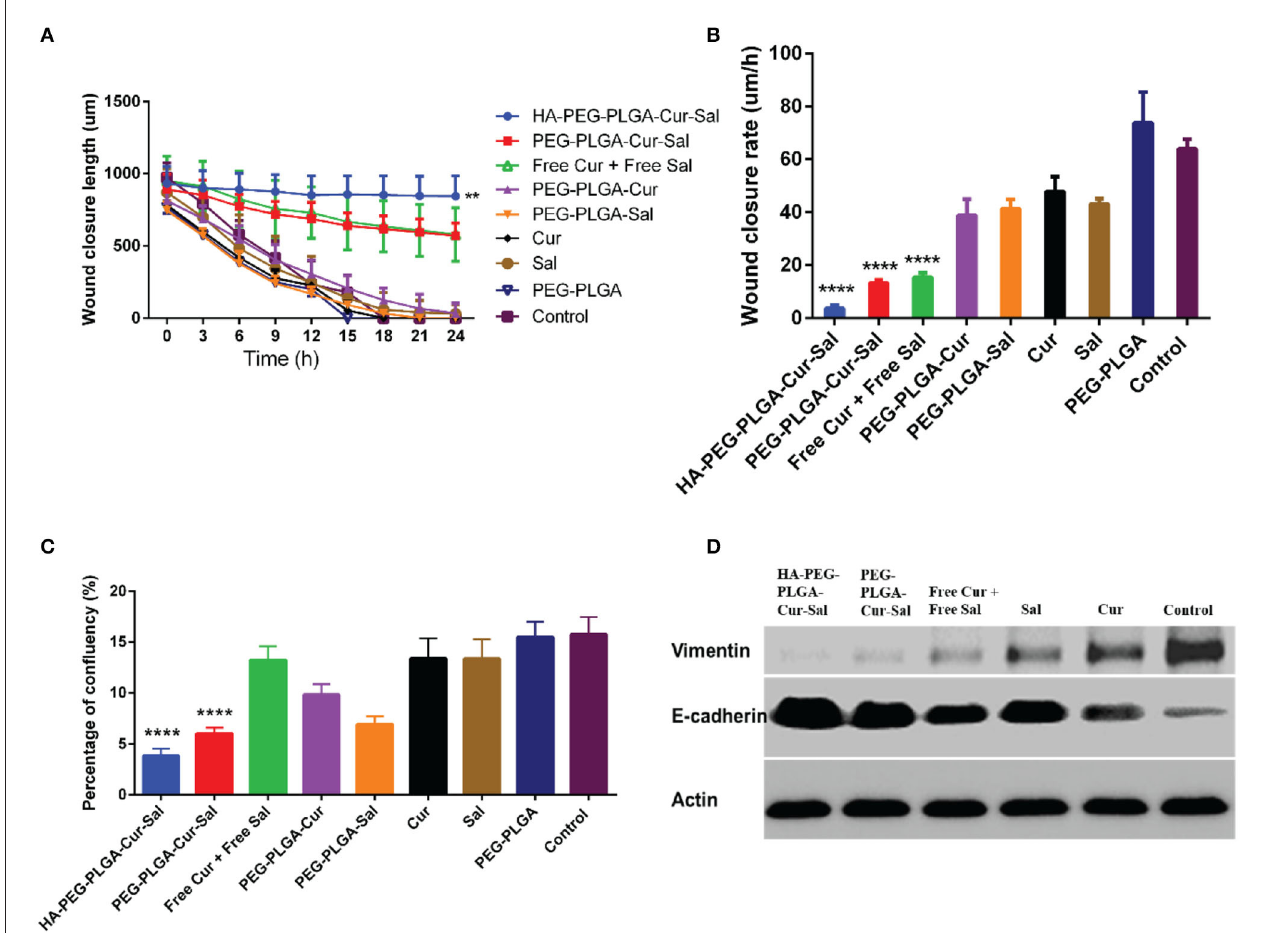
FIGURE 4 | Cell migration behavior after treatment of PEG-PLGA-Cur, PEG-PLGA-Sal, PEG-PLGA, Cur, and Sal against CSCs using wound healing assay: (A) wound closure length, (B) wound closure rate, and (C) percentage of confluency of wound healing assay. (D) Expression of epithelial–mesenchymal transition markers of HA-PEG-PLGA-Cur-Sal, PEG-PLGA-Cur-Sal, free Cur + free Sal, Cur, and Sal. Values are means ± standard deviations ( n = 5, S.D.) (** p < 0.01, **** p < 0.0001).